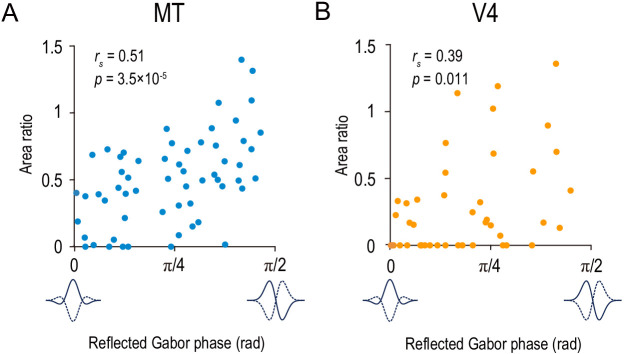
The area ratio is correlated with the symmetry of the disparity-tuning curve as quantified by the Gabor function’s phase parameter in MT and V4.The area ratio is plotted against the best-fitted values of the phase parameter of the Gabor function for 59 MT neurons (A) and 43 V4 neurons (B). The analyses were performed in the same population of neurons as in Figure 6.